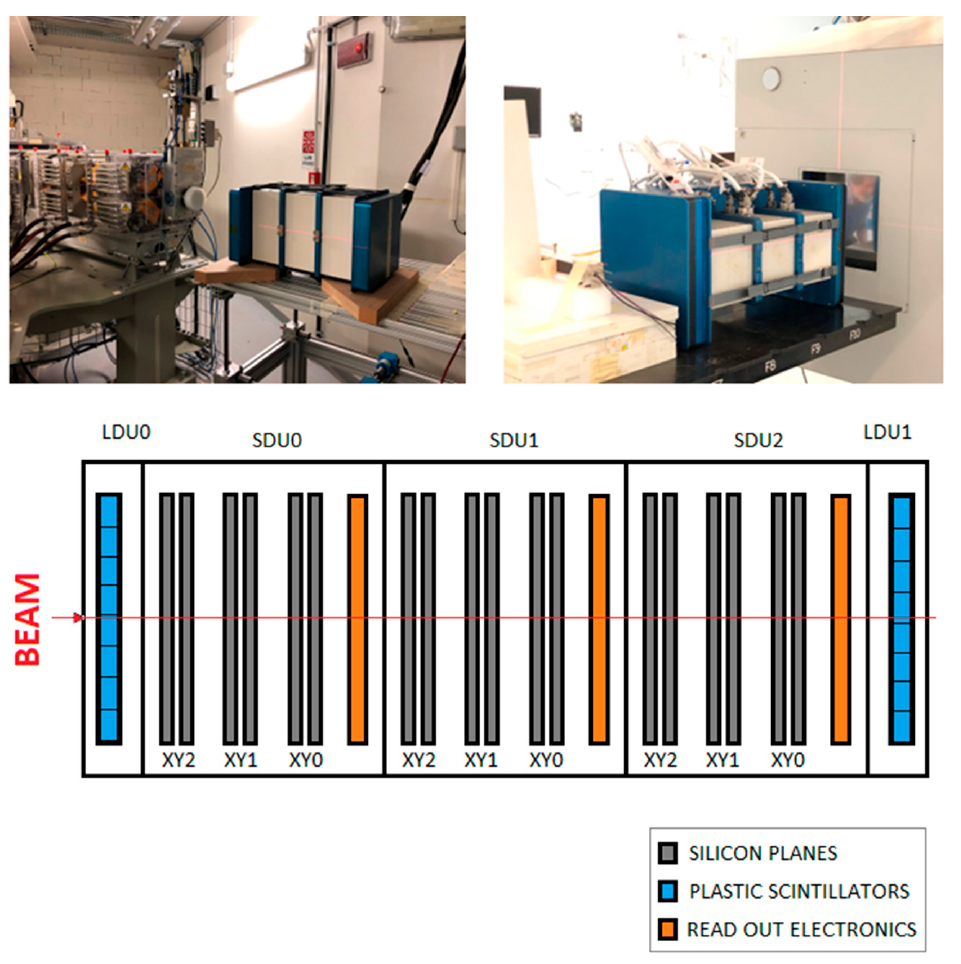
Figure 3. Session measurements at TIPFA ( left ) and CNAO ( right ) particle accelerator facilities and a sketch of the experimental set up (dimensions of components are not in scale); the names of the components of LIDAL (SDUs and LDUs) are specified. On the bottom of the figure, the names of the planes are specified (note that XY2 refers to the couple of planes X2 and Y2, the same for the